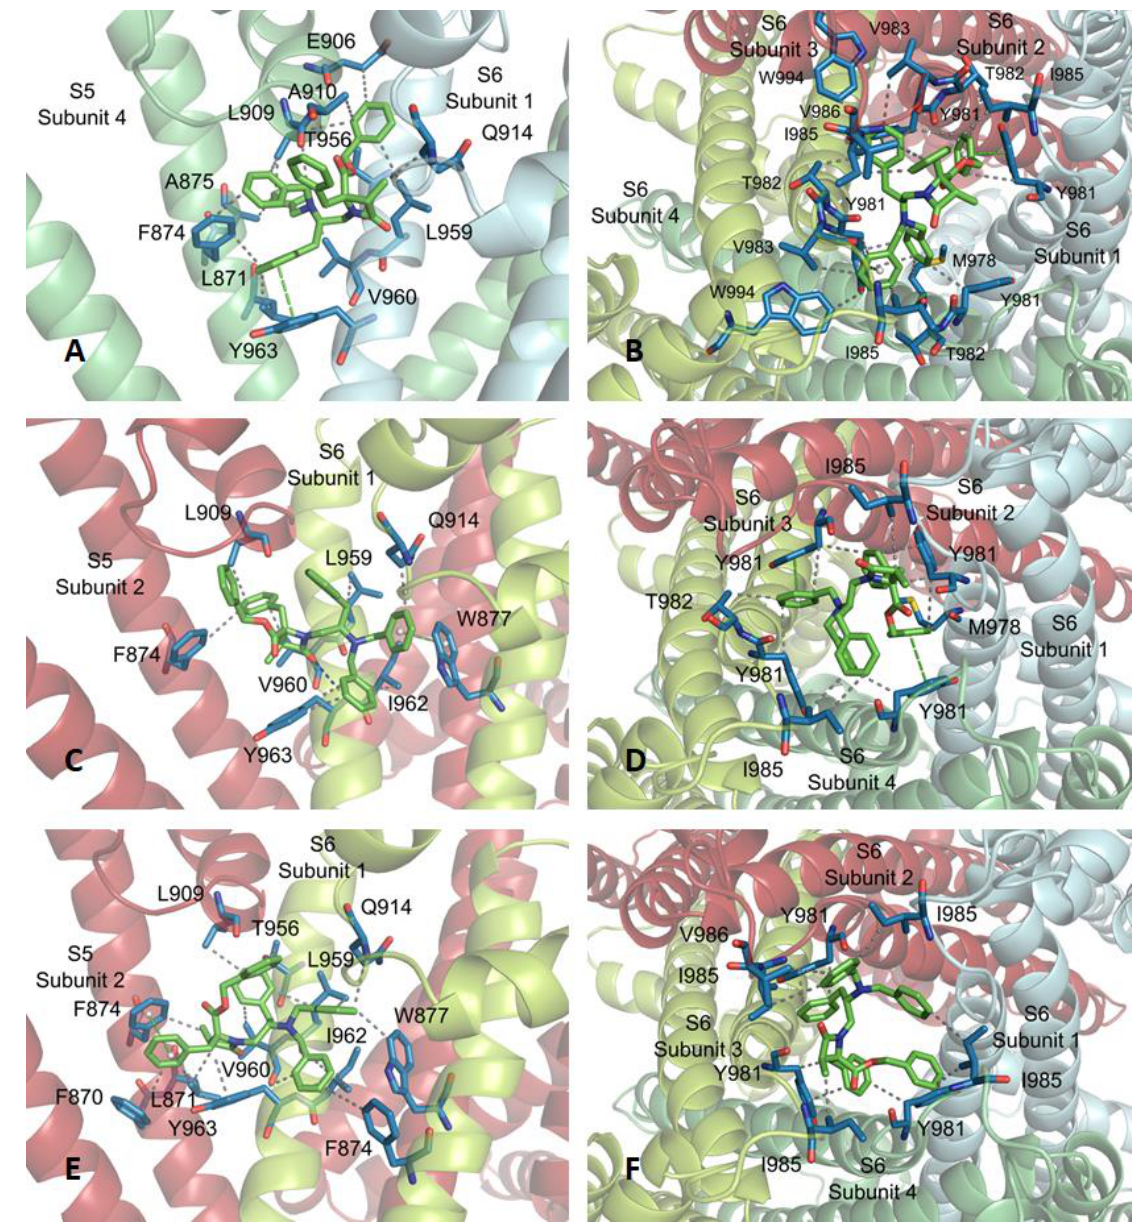
Figure A3. Subsite 1 ( A ) and 2 ( B ) found for β -lactam 13 . Subsites 1 ( C ) and 2 ( D ) found for β -lactam 14 . Subsite 1 ( E ) and 2 ( F ) found for β -lactam 15 . WdV interactions are indicated by dotted gray lines, and π–π stacking by centroids and non-continuous pale green lines. Channel residues involved in the interactions are shown in blue and labelled.